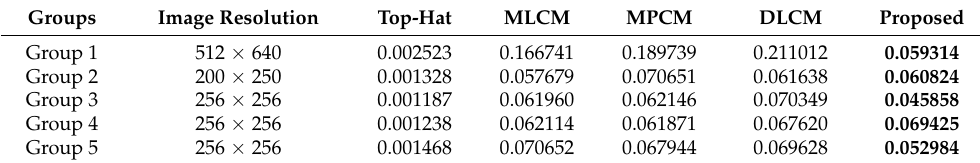
Table 3. Real-time performance evaluation parameters (units: s).